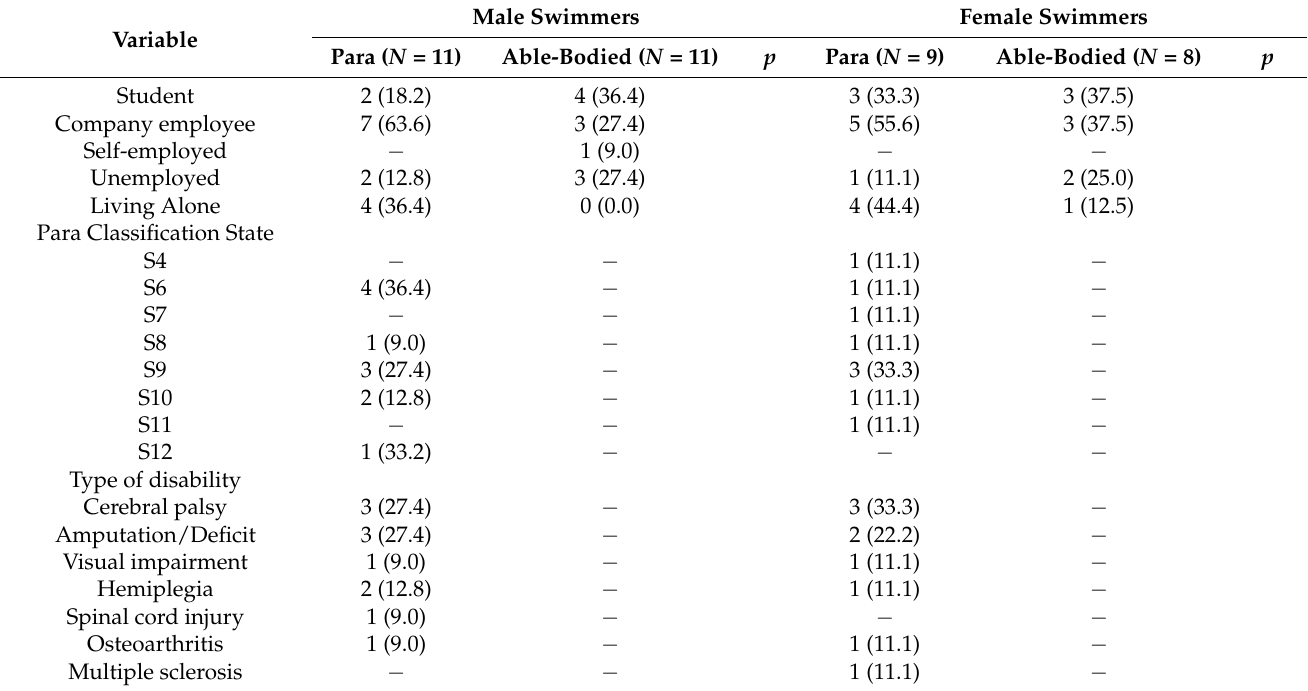
of Emergency The changes in LSA at baseline, during, and at follow-up after the state of emergency are shown in Figure 2.